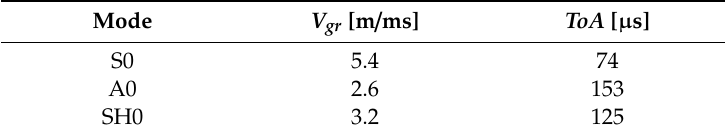
Table 1. V gr and ToA of the three potential